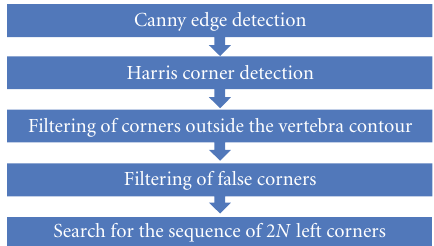
Figure 5: Procedure to detect corners of each